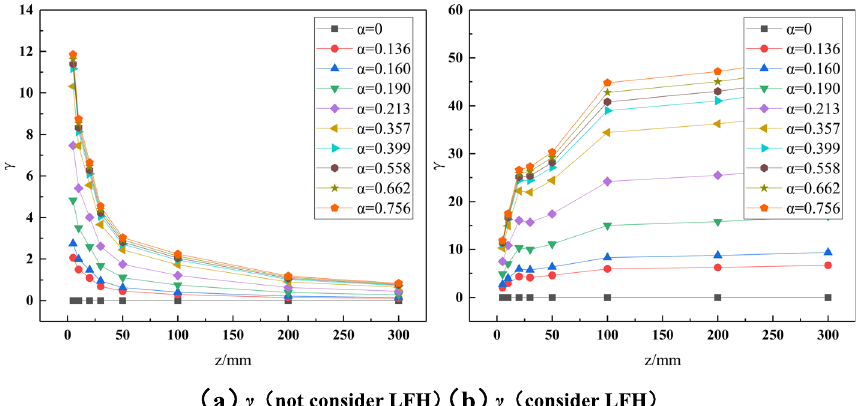
Fig. 13 The magnetic characteristic index γ of the specimen under different lift-off heights. a γ (not consider LFH). b γ (consider